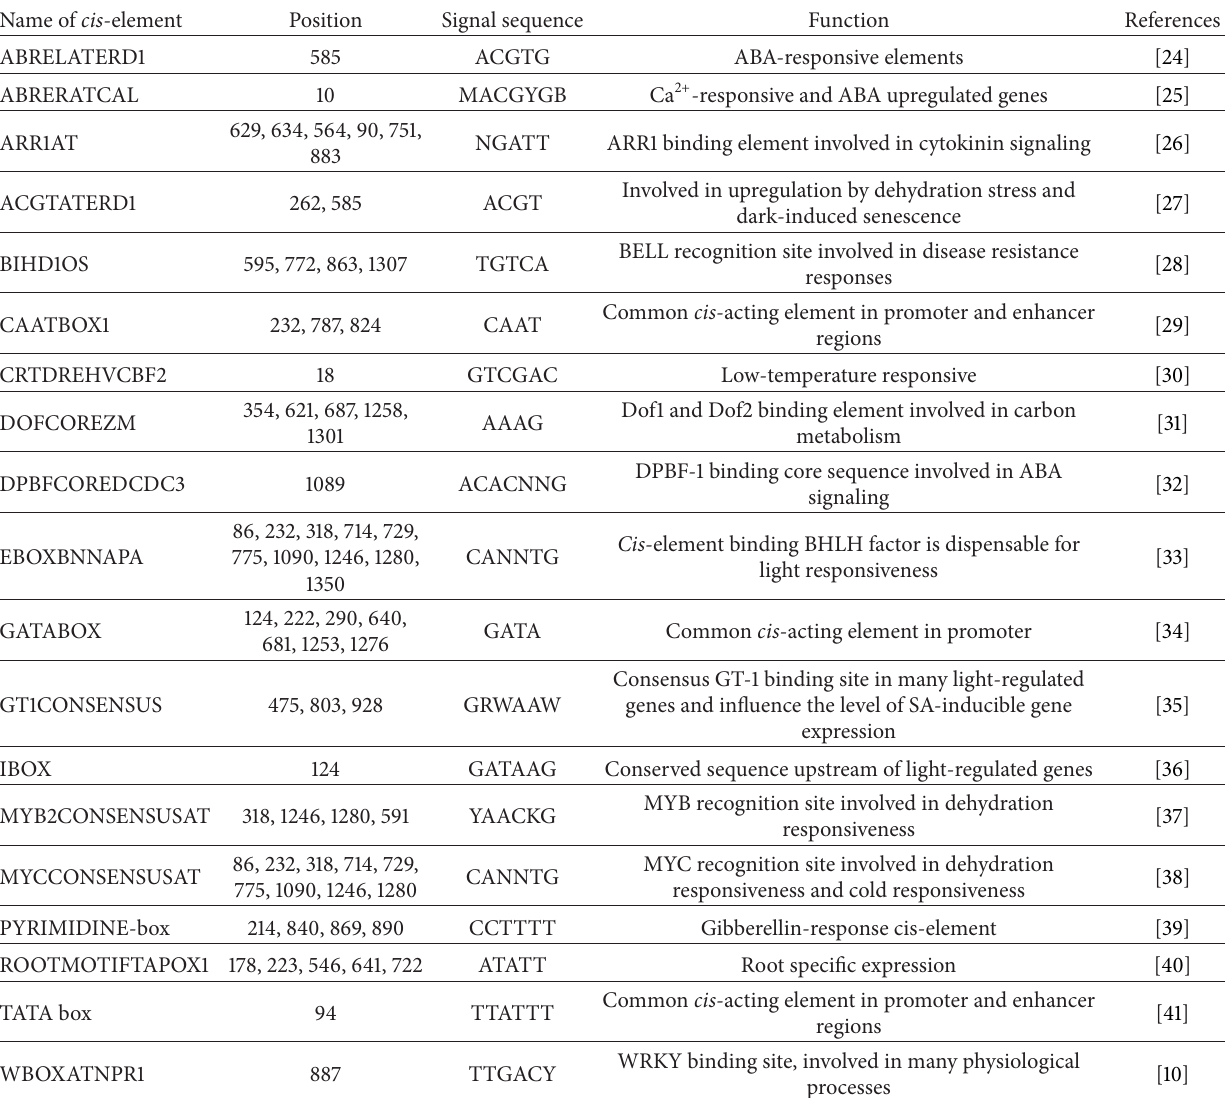
Table 3: Putative cis -acting regulatory elements identified in the promoter of GbWRKY2 using PLACE (http://www.dna.affrc.go.jp/PLACE/) and the Signal Scan Program PlantCARE (http://bioinformatics.psb.ugent.be/webtools/plantcare/html/)